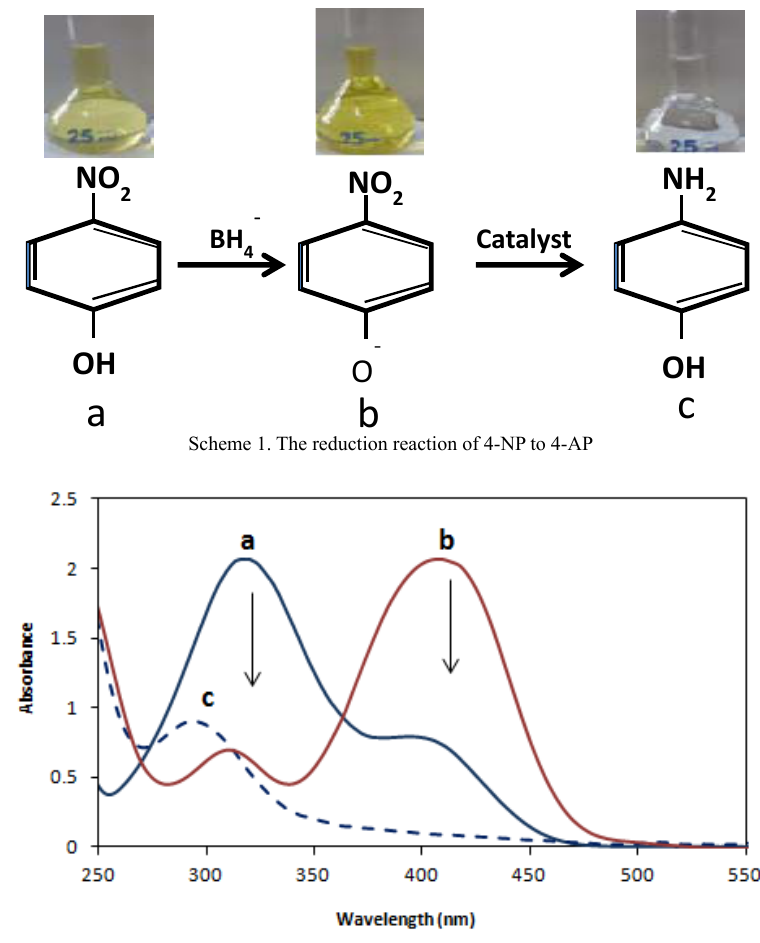
Fig. 13. UV-Vis absorption spectra of 4-NP (a); 4-NP + NaBH4 (b) and 4-AP Fig. 13 UV-Vis absorption spectra of 4-NP (a); 4-NP + NaBH4 (b) and 4-AP (c).